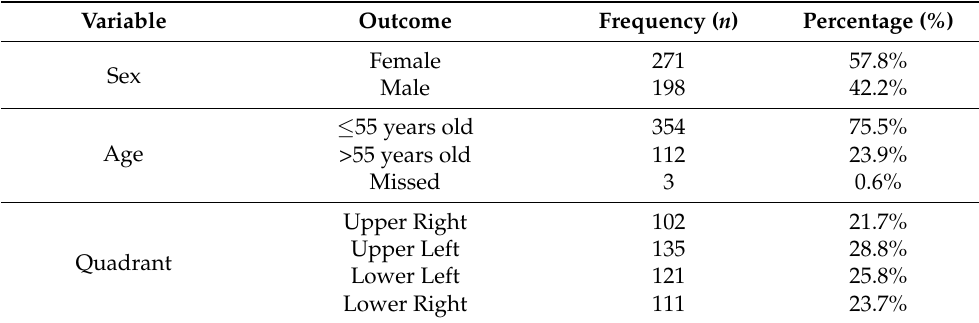
Figure 2. Luting cements that were used in this study: ( a ) Harvard Premium Flow; ( b ) Enamel Plus; ( c ) Filtek Ultimate Flow; ( d ) Filtek Bulk Fill Flowable; ( e ) Filtek Ultimate; ( f ) Relyx Ultimate; ( g ) Relyx Unicem, Palacky University Hospital, 2014–2018 ( n = 469). While the majority of used cements were composite-based (83.6%), almost half of them were with high viscosity (52.5%). The year 2016 had the highest share of composite restorations (36.7%), while the year 2018 had the lowest share (4.1%). Until 2019, 398 (84.9%) of the restorations survived and remained functional, while 36 (7.7%) broke down, 19 (4.1%) had leaked filling, and 16 (3.4%) manifested secondary caries underneath or around (Table 1). Table 1. Demographic and clinical characteristics of composite restoration recipients, Palacky Univer- sity Hospital, 2014–2018 ( n =